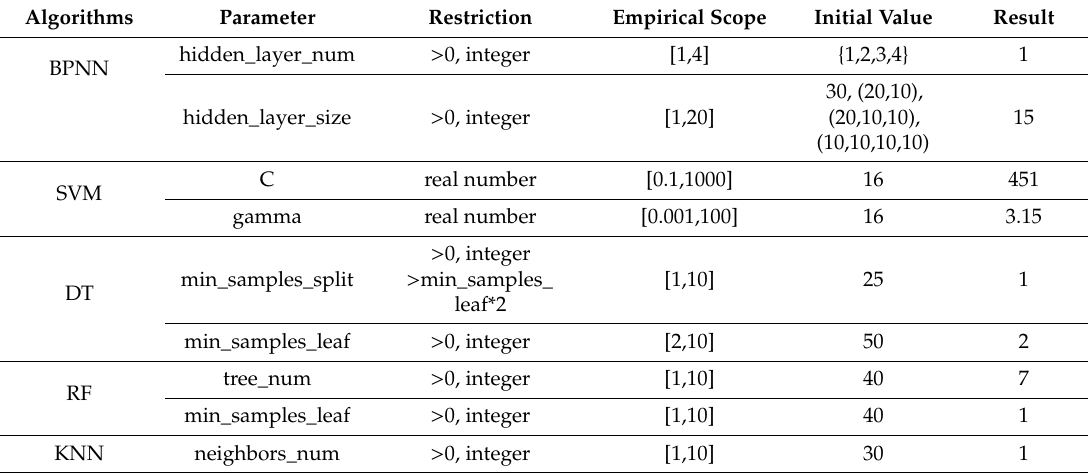
Table 4. Optimum hyper-parameters in